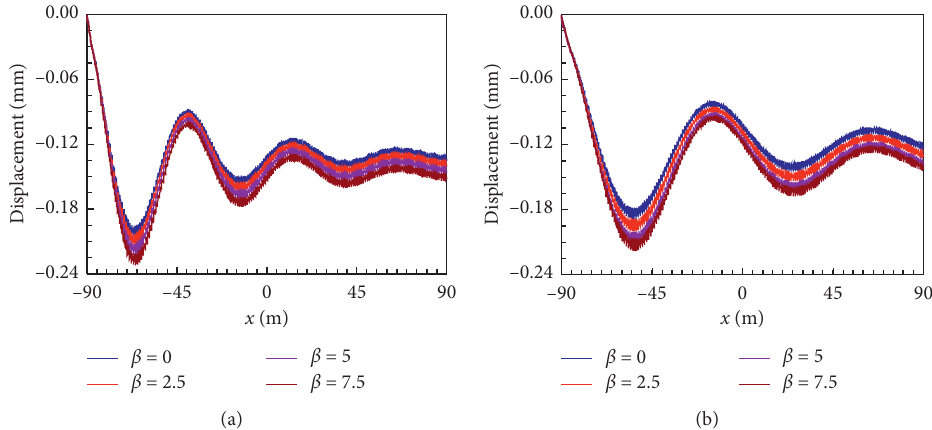
Figure 13: The history of vertical displacements of the wheel axle corresponding with location of the moving vehicle: (a) v � 50m/s and (b) v � 75m/s.